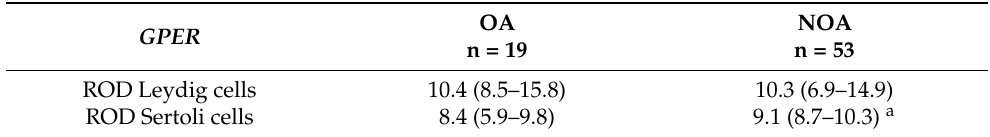
Table 8. Intensity of immunohistochemical staining for GPER expression as relative optical density (ROD) of DAB brown reaction product. GPER